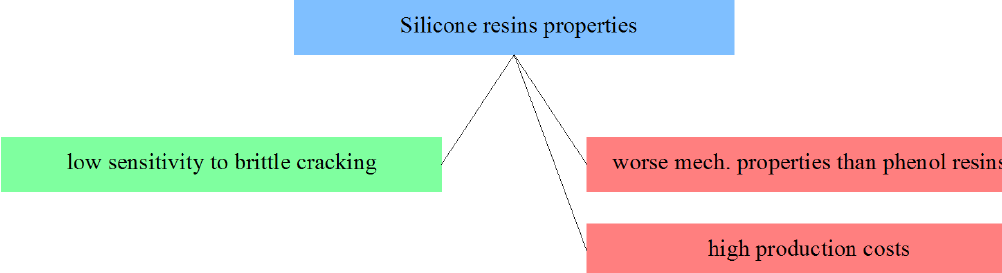
Figure 5: Selected silicone resins properties from the point of view of applicability in friction materials